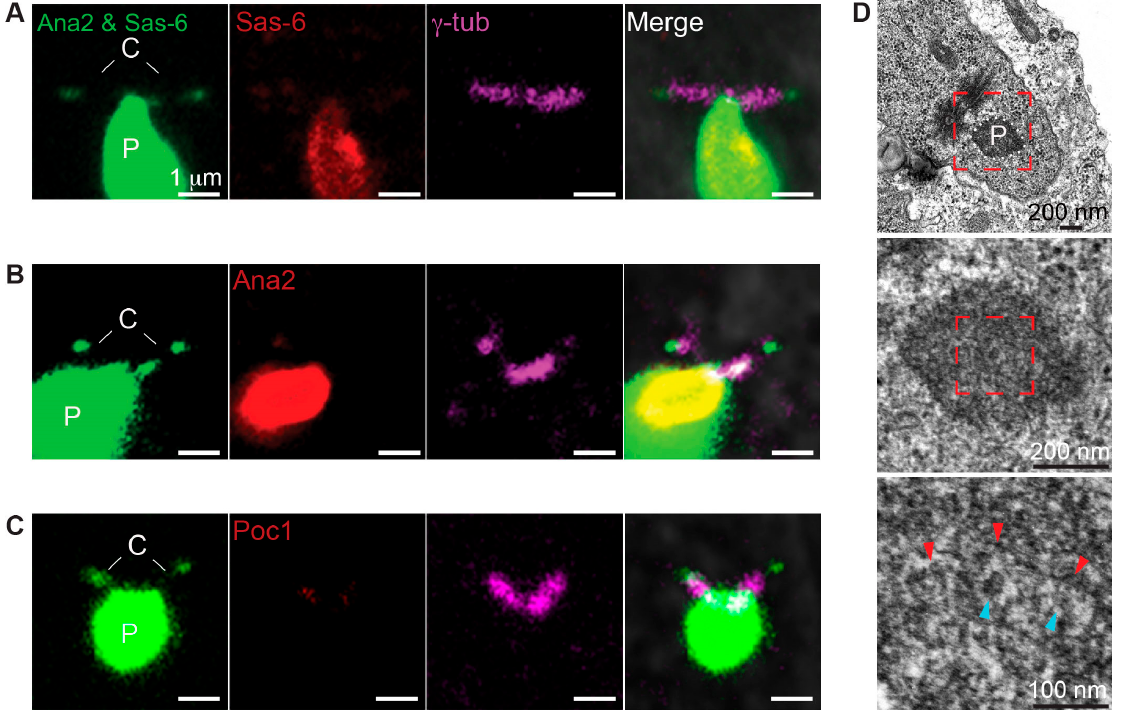
Figure 5. Poc1 is essential for proper formation of PCL-like structure . ( A – C ) Sas6/Ana2 Particles in poc1 W87X homozygote were attached to the γ -tubulin labeled centrioles. Sas-6 antibodies labeled the particle ( A ), Ana2 antibodies labeled the particle ( B ), and Poc1 antibodies weakly labeled the centrioles and did not label the particle ( C ). ( D ) Sas6/Ana2 particles in poc1 W87X homozygote had deformed PCL-like structures in mature spermatocyte. Low electron microscopy magnification (upper row) showed PCL-like structures near the electron dense area, outlined with white dotted lines. Intermediate and high magnification showed that PCL-like structures were composed of fragmented tubule-like structures (blue arrowhead) and electron-dense material (red arrowhead) in mature spermatocyte (middle and lower row).